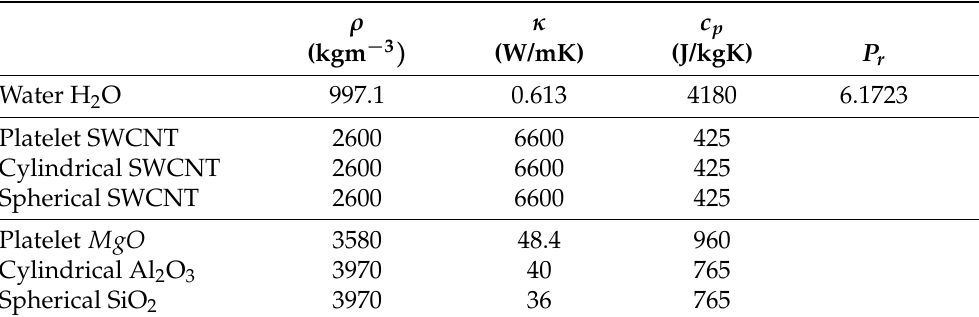
Table 1. Details of platelet magnesium oxide nanoparticles from Animasaun et al. [35], cylindrical alu- minum oxide nanoparticles from Ref. [36], spherical silicon dioxide nanoparticles from Refs. [36,37], single-wall carbon nanoparticles by Kandasamy et al. [38], and water.